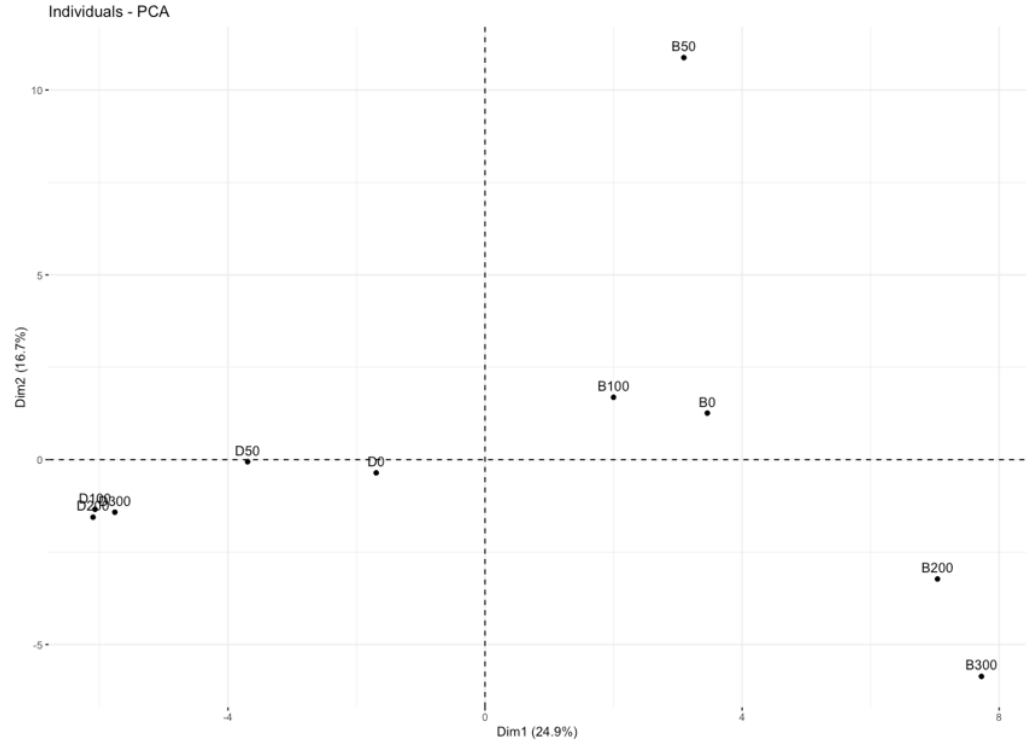
Figure 5. Principal component analysis performed on relative densities (replicates samples pooled) of living fauna for sites B and D.